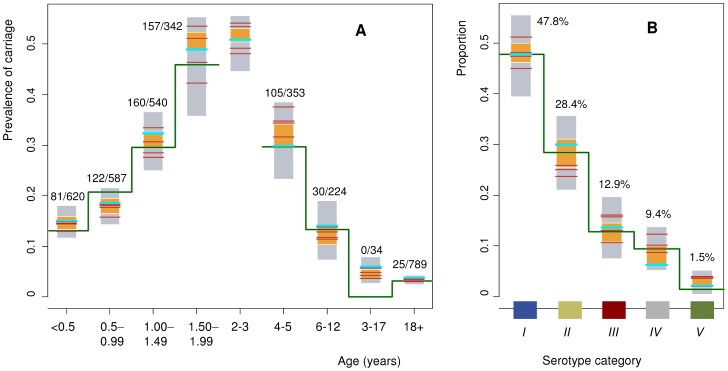
Age-specific prevalence of carriage and the serotype distribution.(A) The prevalence of pneumococcal carriage in 9 age windows (<0.5, 0.5–0.99, 1.00–1.49, 1.50–1.99, 2–3, 4–5, 6–12, 13–17, 18+ years of age). The blue and red horizontal lines correspond to the model simulation using the 5 most optimal parameter combinations having the 5 highest (median) likelihood values, with the blue lines indicating the most optimal combination (Table 1). The ranges of model predictions are shown for each age window in grey colour. These correspond to the 50 most optimal parameter combinations. The point-wise intervals containing 75% of these 50 prevalence values are shown in yellow. The observed proportions (number of positive samples/number of samples) are indicated by the green line segments (there were no observations in age window 2–3 years). These data originate from 3 studies as described in the text. (B) The serotype distribution for the five serotype categories. The simulation results and the observed data are presented as in panel A. The observed data originate from a study of pneumococcal carriage in children <2 years of age (Table 1; [25]).